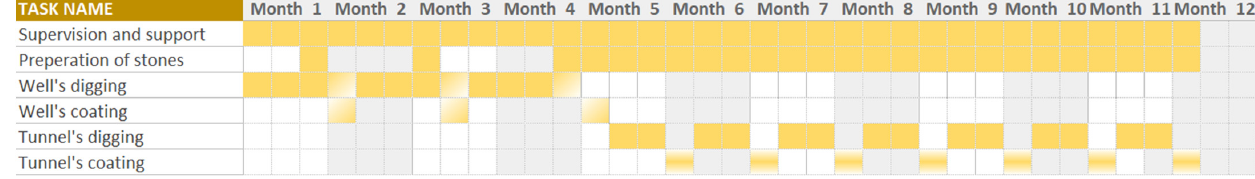
Figure 26. Indicative Gant chart of the duration of a module.